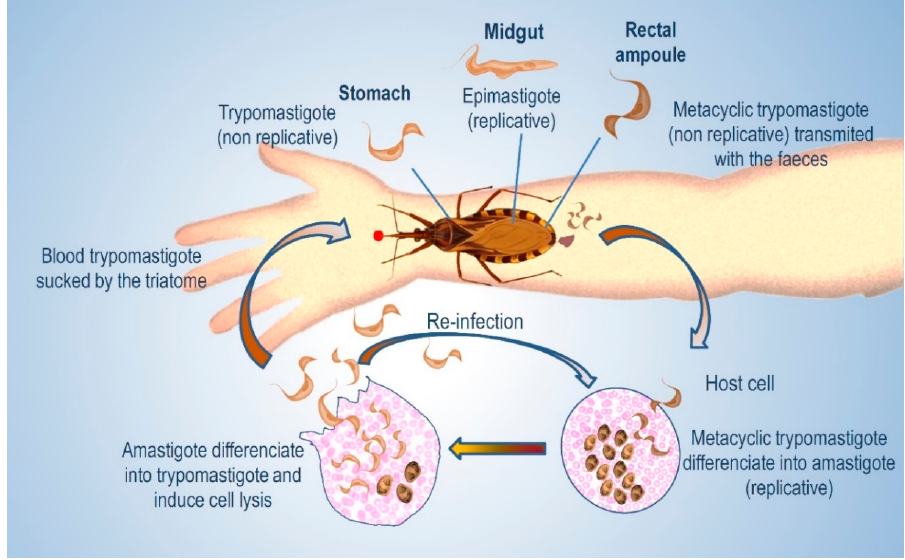
Figure 1. Life cycle of T. cruzi .